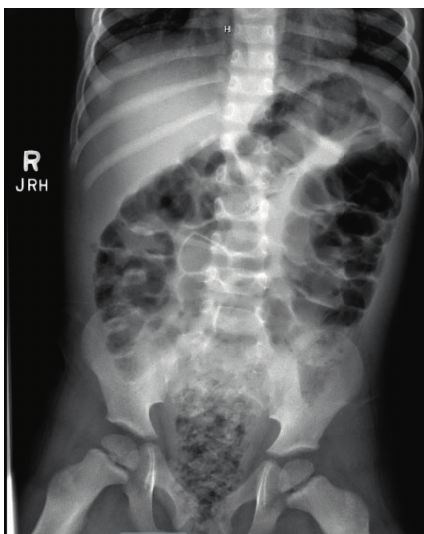
Figure 2: Abdominal X-ray, supine view. Following 2 days on stool softener and representation to the ED, there is mild gaseous dis- tention of the visualized large colon with a moderate degree of fecal material within the rectum and rectosigmoid colon, not subse- quently moved by mineral oil enema.